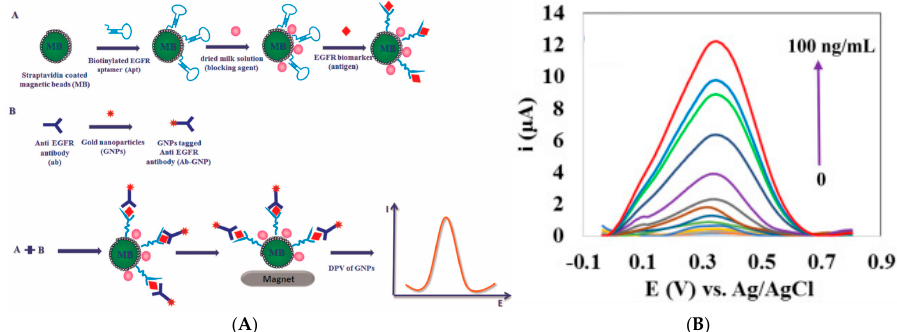
Figure 31. ( A ) Magnetic beads functionalized with capture aptamers, and transduction using AuNPs-labelled signaling antibodies in a sandwich assay; ( B ) Corresponding DPVs for different concentrations of EGFR in the range of 1–40 ng mL − 1 . Reprinted from [162], Copyright 2015, with permission from Elsevier.